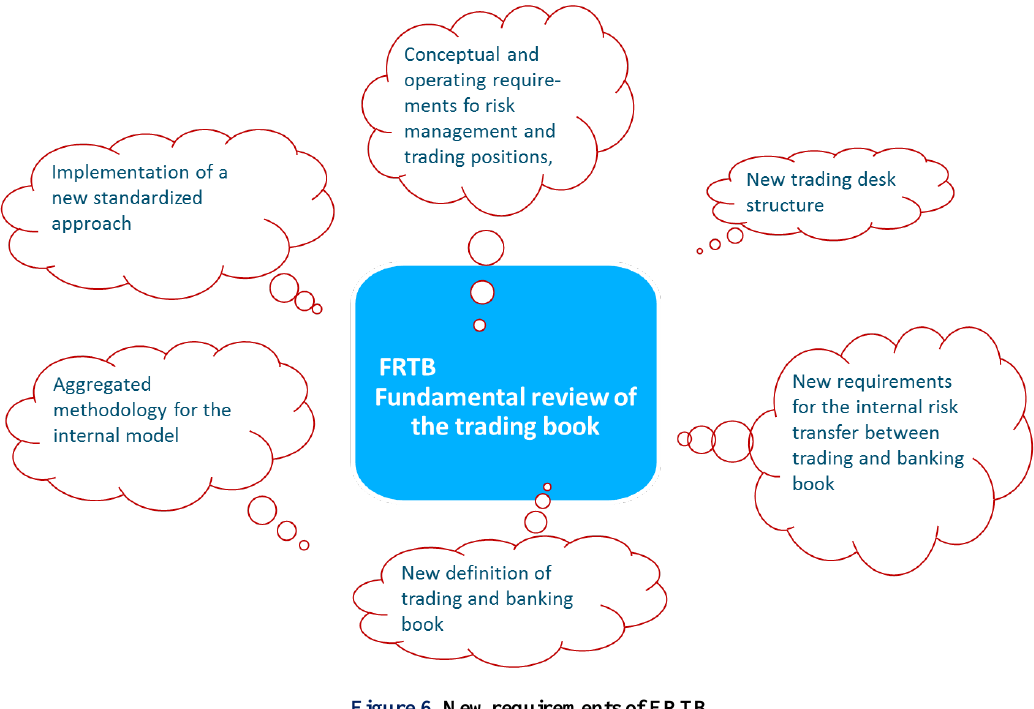
Figure 6. New requirements of FRTB.